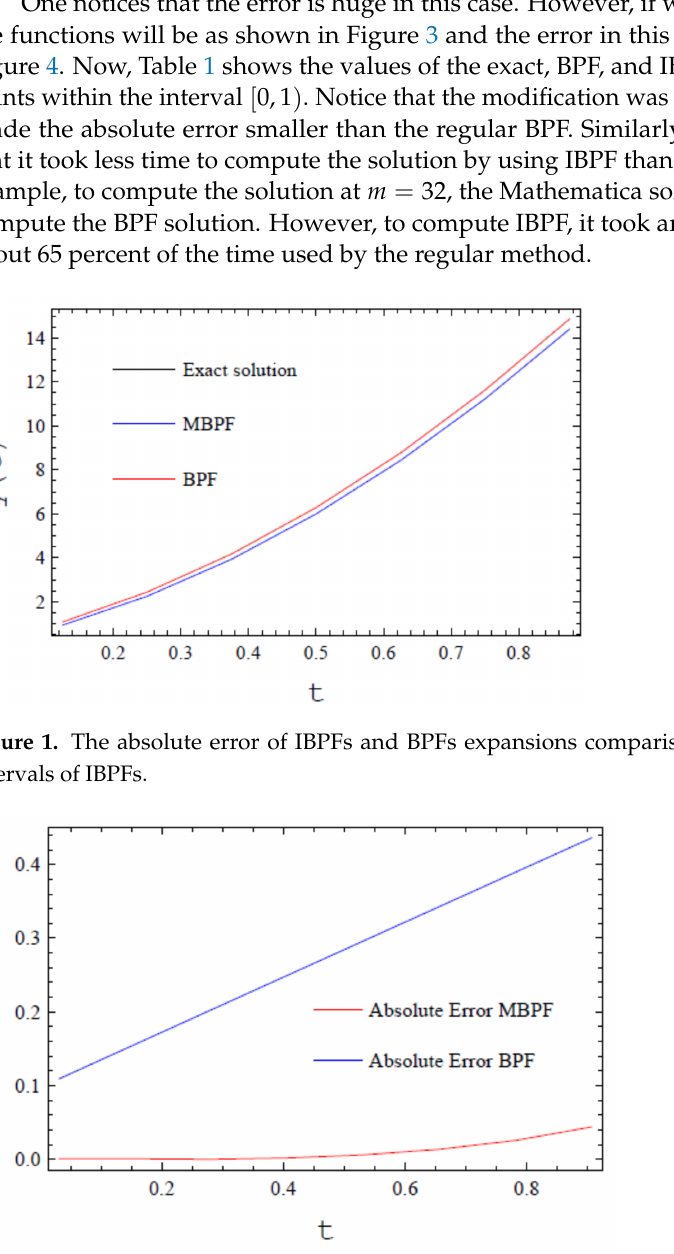
Figure 2. The absolute error of IBPFs and BPFs expansions comparison at the midpoints of the intervals of